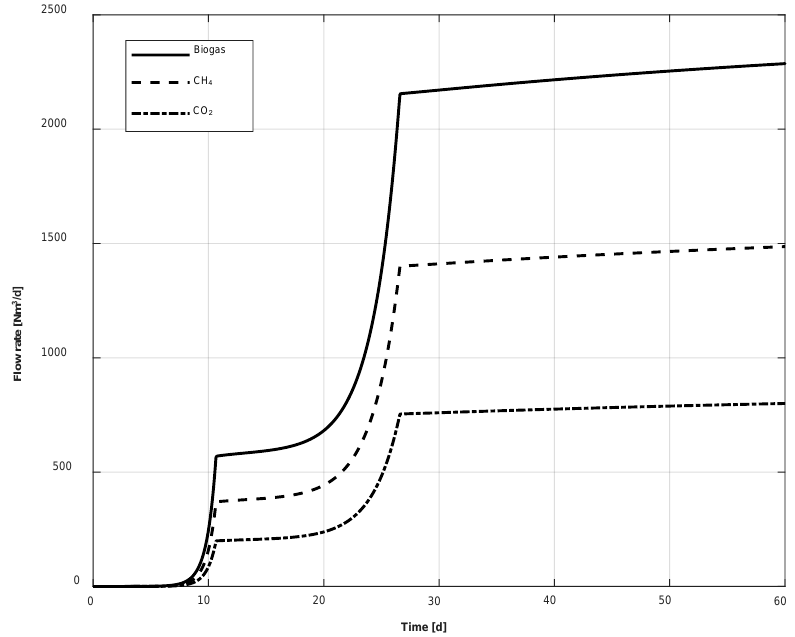
Figure 5. Biogas, CH 4 , and CO 2 flow rate at the end of PFR. Biogas production along the PFR is roughly constant, as shown in Figure 6a. For advanced slices of PFR, the beginning of the biomethane production and of the exponential phase is forwardly shifted from the time point of view. The output waste temperature, which varies from slice to slice in the PFR, is one of the most important parameters of the biological model, affecting the metabolic activity of bacteria into the digester. The higher the temperature, the faster the development of the biological model, see Figure 6a,b.